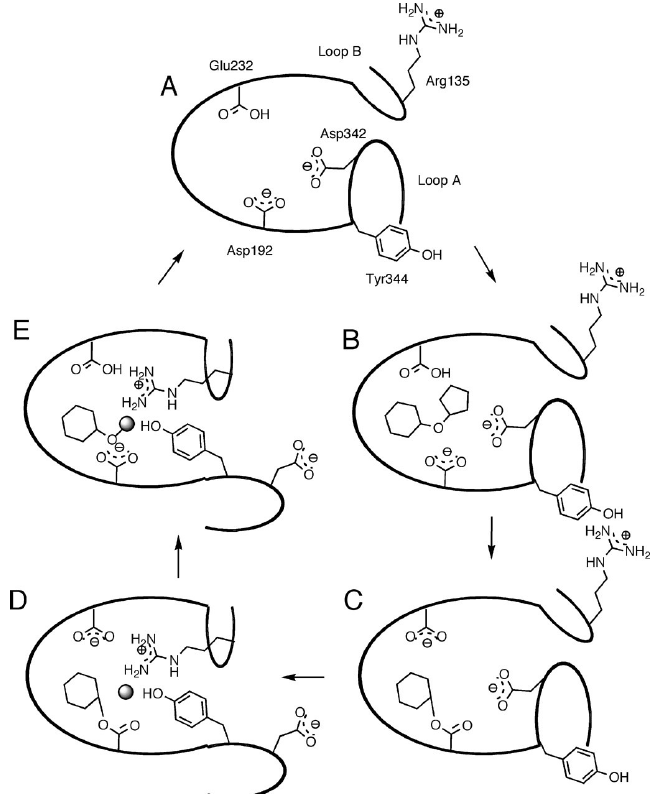
Figure 7. Reaction mechanism scheme for sucrose transglucosylation in the active site of a model SP enzyme. Step ( A ) corresponds to the apoenzyme, which binds the substrate sucrose in step ( B ), to form the covalent intermediate in step ( C ), with fructose leaving the active site. In step ( D ), the glucosyl intermediate reacts with either phosphate ions (phosphorolysis) or water (hydrolysis). Phosphate/water is depicted as a gray sphere. Step ( E ) shows the product-bound form of the enzyme (hydrolysis, glucose; and phosphorolysis, glucose 1-phosphate). Only the carboxylate groups of Glu232 and Asp192 are shown for clarity. The glucosyl and fructosyl groups are represented by hexagons and pentagons, respectively. Figure from reference